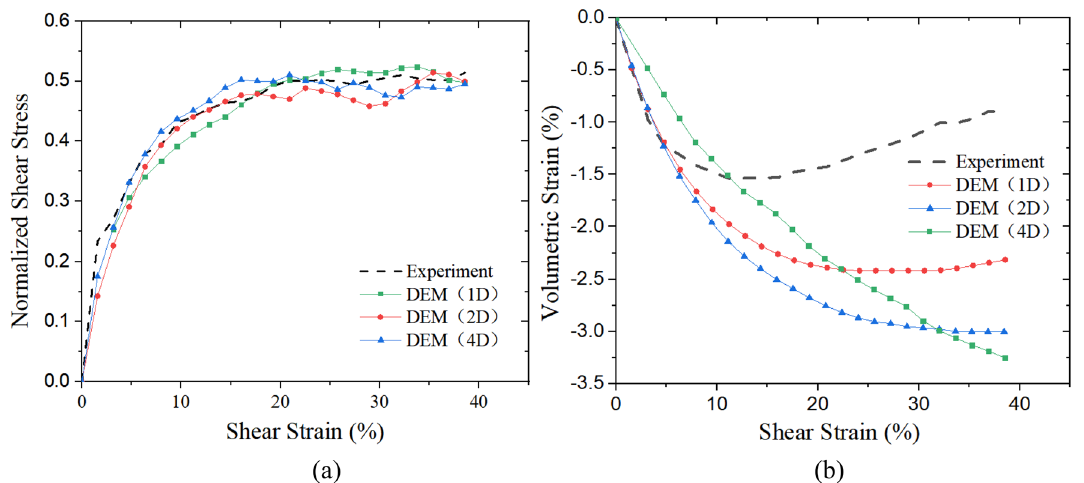
Figure 3. Macro-mechanical behavior in DEM models: ( a ) Shear stress and shear strain relations ( b ) Shear strain and volumetric strain